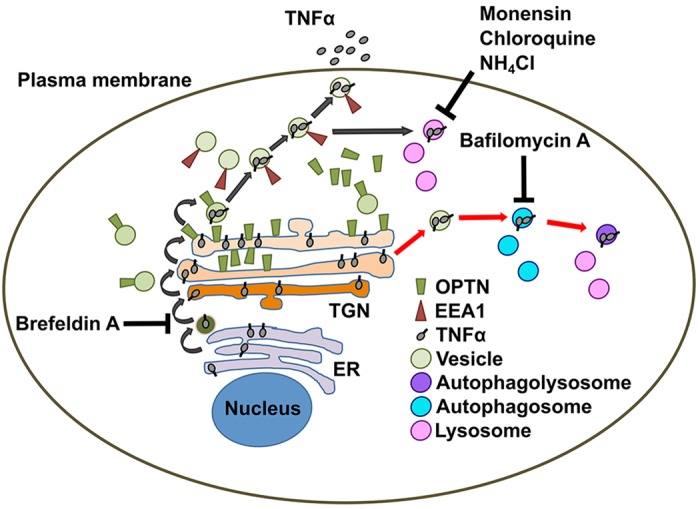
Schematic diagram of TNF trafficking in murine macrophages. TNF is translated in the endoplasmic reticulum (ER), transferred to the trans-Golgi network (TGN) for post-translational modification before packaging into vesicles, and is trafficked via early endosome antigen 1 (EEA1)-positive vesicles to the plasma membrane for secretion (black arrows). In the absence of OPTN, a greater proportion of TNF is trafficked and degraded via bafilomycin-A-dependent pathways (red arrows). Monensin, chloroquine and NH4Cl inhibit lysosomal function, whereas brefeldin A blocks ER-to-Golgi transfer.